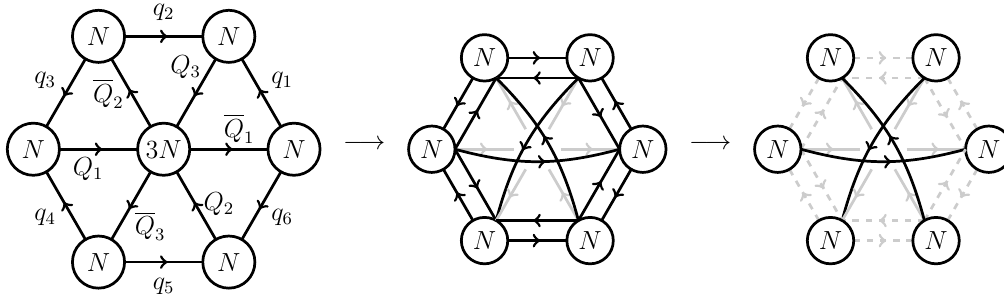
Figure 3 . When the theory is probed at intermediate scales µ < Λ 3 N , the unit cell evolves towards the moose diagram shown on the right. First, on the left, we show the Λ 3 N (cid:28) µ < M ? unit cell for weakly coupled SU(3 N ) . After SU(3 N ) confines, the light degrees of freedom include the SU( N ) × SU( N ) meson operators, shown in the middle diagram either crossing the center of the unit cell or connecting adjacent SU( N ) nodes on its boundary. Together with the original SU( N ) × SU( N ) bifundamentals q i , the meson operators on the edge of the hexagon acquire O ( λ i Λ 3 N ) masses from the plaquette operators W ∼ QQq → ( QQ ) q . The rightmost diagram shows the theory at scales µ < λ Λ 3 N , after integrating out the vectorlike quarks. In this infrared limit, the only light SU( N ) - charged matter fields are the mesons that pass through the center of the unit